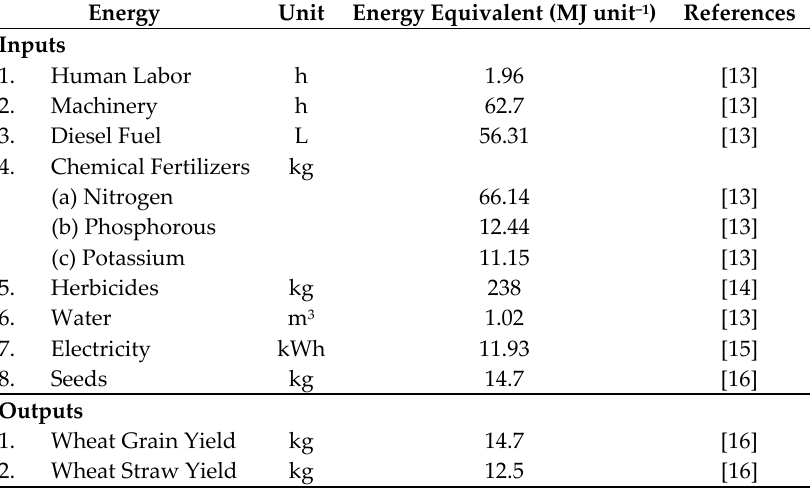
Table 1. Energy equivalents of inputs and outputs in agricultural